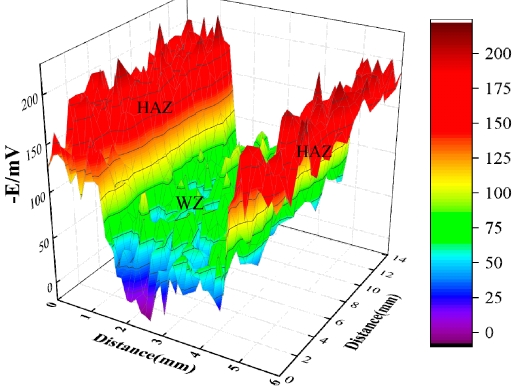
Figure 12. Work potential distribution of welding joints.